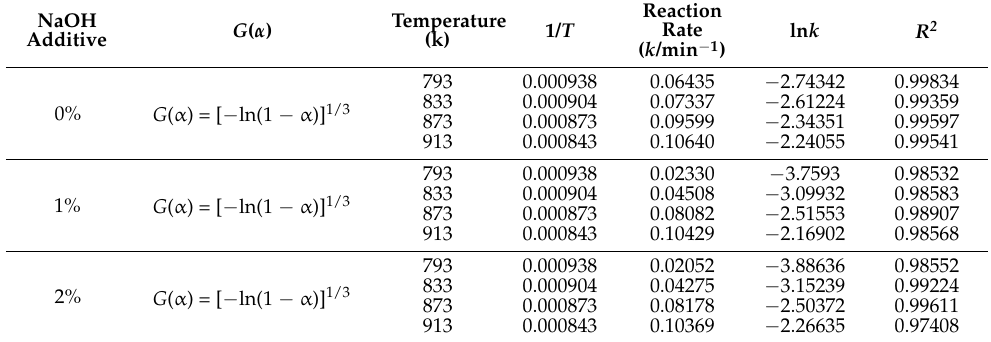
Table 3. Reaction rate constant and linear correlation coefficient of reduction at different temperatures.